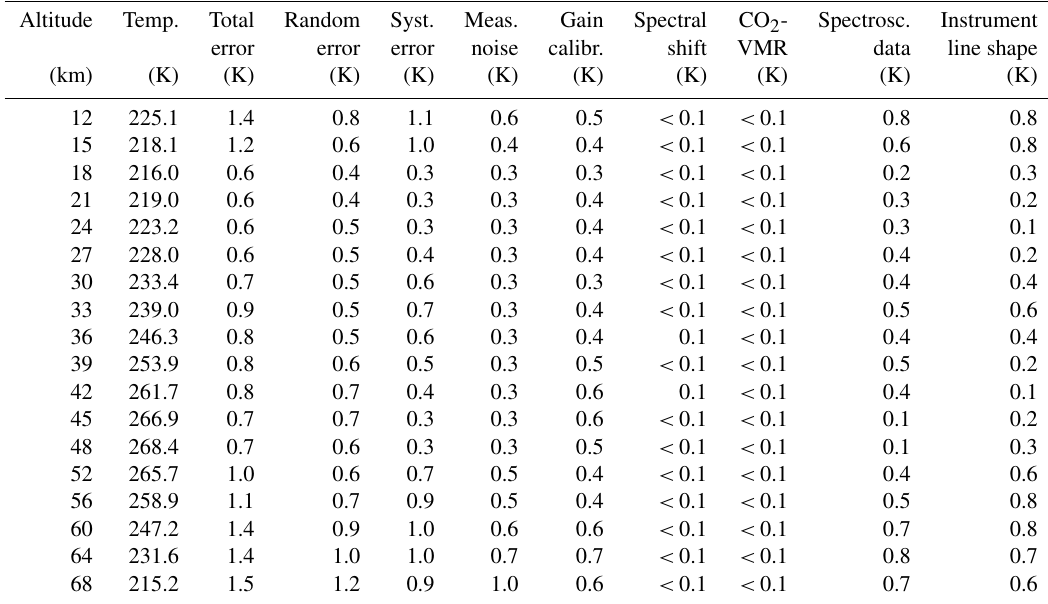
Table A5. RR data temperature error budget for northern midlatitude summer day. All uncertainties are 1 σ . Altitude Temp.